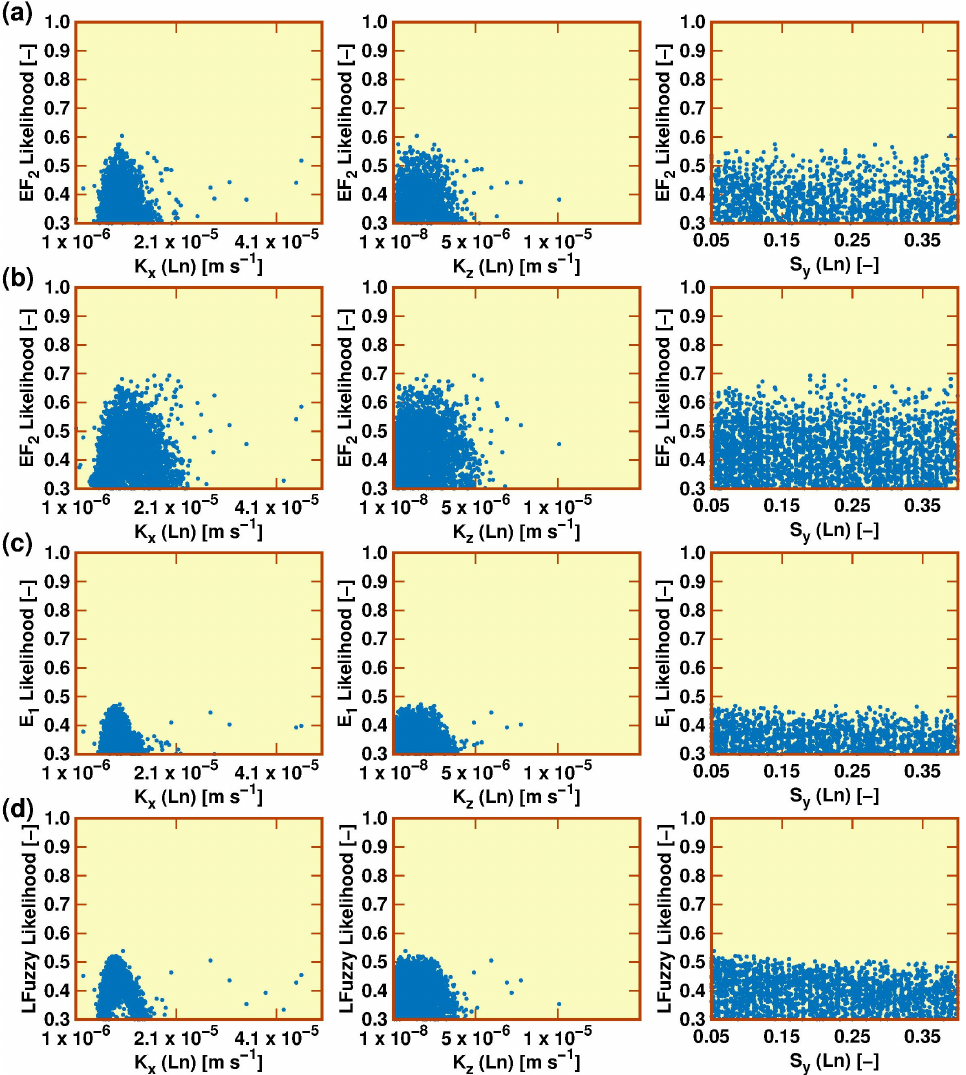
Figure 3. 5. Figure 5. Scatter plots of behavioural parameter sets (likelihood target was 0.25), for three of the inspected parameters, in the validation period (after the Bayesian-type update of likelihood measures) and after conditioning based on observed streamflow at the outlet of the catchment: ( a ) using the EF 2 index and without considering H-Q data uncertainty in the analysis; ( b ) using the EF 2 index and considering H-Q data uncertainty in the analysis; ( c ) using the E 1 index and considering H-Q data uncertainty in the analysis; and ( d ) using the linear fuzzy likelihood measure ( LFuzzy ) and considering H-Q data uncertainty in the